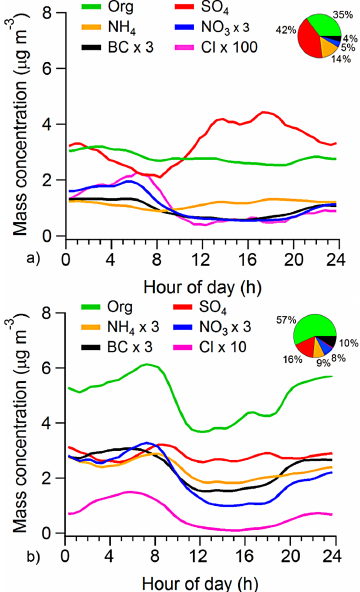
Fig. 4. Diurnal cycle of OA, SO 2 − wet (a) and the dry (b) seasons. NO − multiplied by 3 and Cl − by 10/100 for scaling. Mean compositions are shown in the pie charts